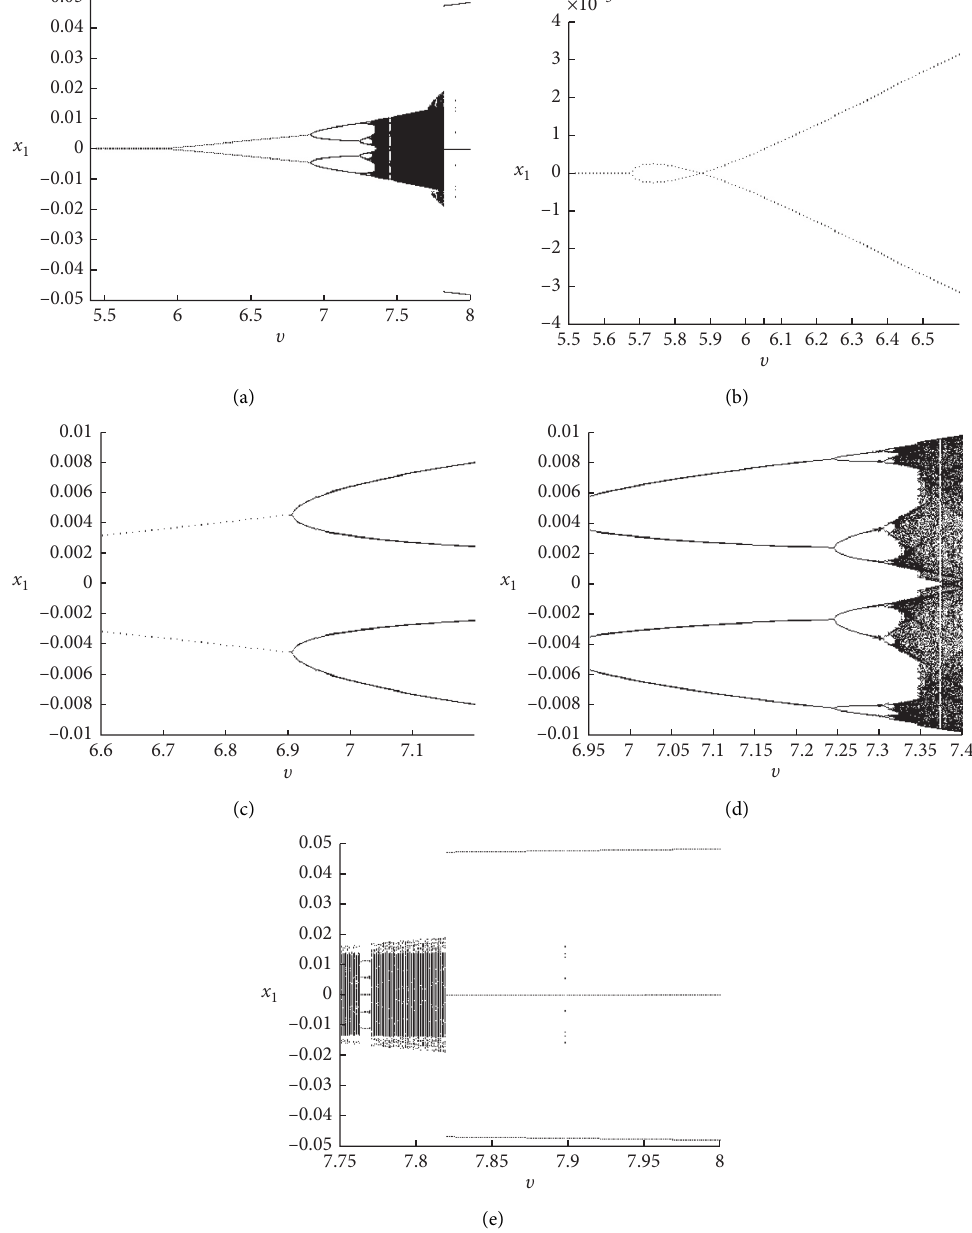
Figure 5: The bifurcation diagrams of the nonlinear system defined by (38) for α � 0 . 005 , β � 0 . 2 , ξ varied. (a) For 5 . 4 ≤ υ ≤ 8 and (b), (c), (d), and (e) for smaller ranges of υ to show finer